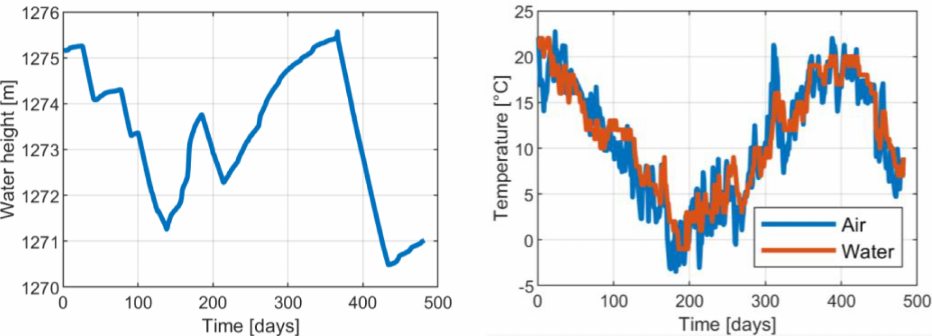
Figure 5. Time series of the reservoir water level (on the left ) and time series of air and water temperatures (on the right